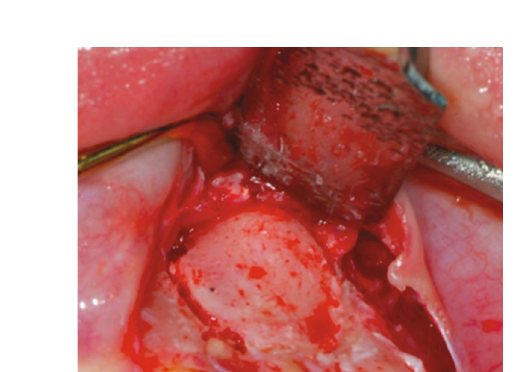
Figure 3: Starting CT.